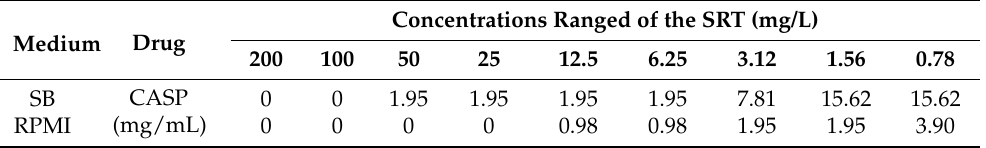
Table 2. MICcb (combined MICs) values for analysis of synergism between sertraline (SRT) and caspofungin (CASP) in assays performed in RPMI medium and Sabouraud (SB)